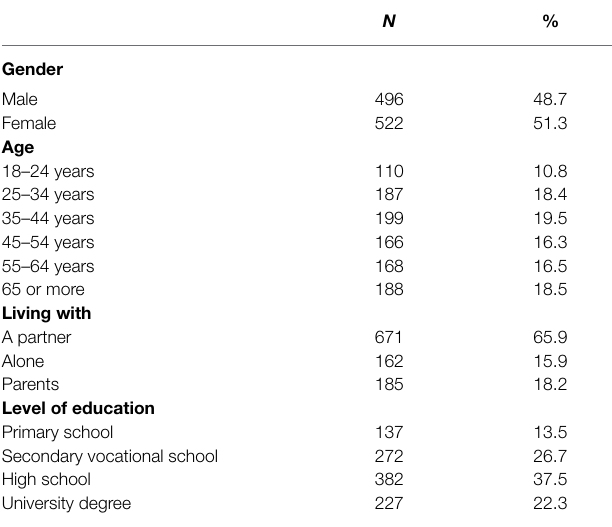
TABLE 1 | Demographic characteristics of the